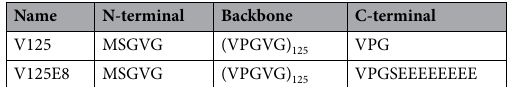
Table 1. The amino acid sequences of synthesized ELPs.